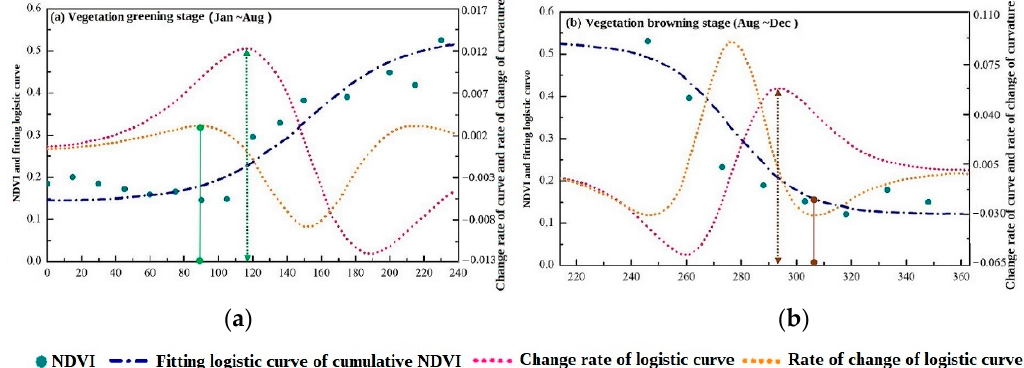
Figure 2. Illustration of the cumulative normalized difference vegetation index (NDVI) on the MP based on logistic regression curves. The change curves of cumulative NDVI in vegetation greening stage ( a ) and vegetation browning stage ( b ). (The SOS_RCC is start of the growing season; EOS_RCC is end of the growing season; SOS_K is maximum curvatures of the stage of vegetation greening and the EOS_K is minimum curvatures of the stage of vegetation browning)